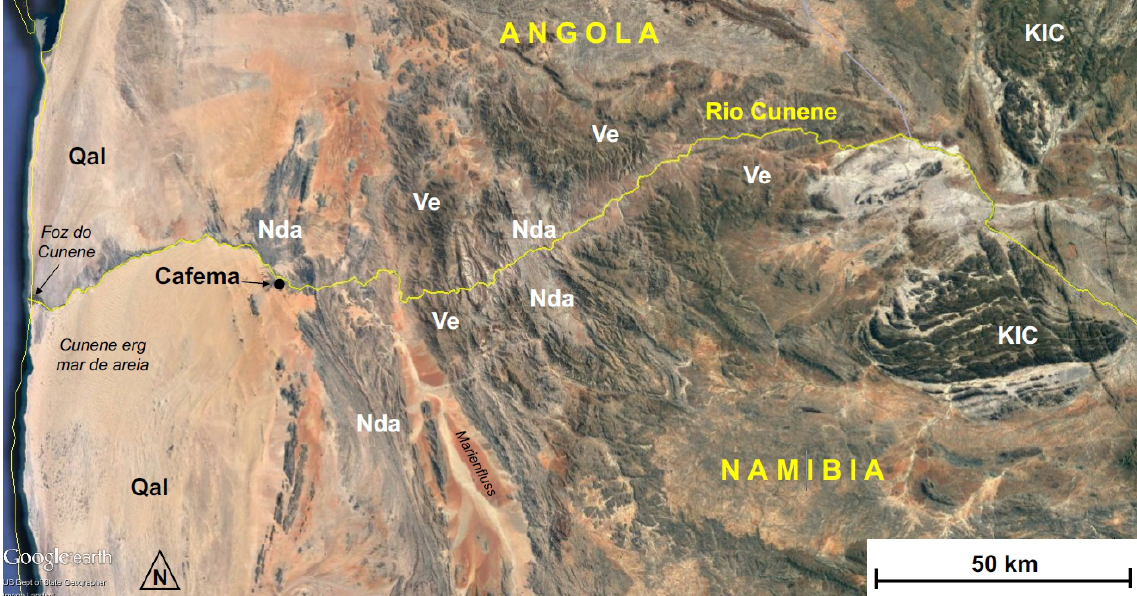
Figura 5. Mapa do sítio do Paleolítico Médio Africano (PMA) Cafema no Google Earth, ao longo do baixo Rio Cunene, fronteira entre Angola e Namíbia. As unidades geológicas de afloramento primário listada na Tabela 3 que contribuem com os clastos do terraço fluvial de Qal. KIC: Complexo Intrusivo Kunene. Ve: Complexo Epupa. Nda - Sequência Damara. Qal: Aluvium Quaternário. Figure 5. Google Earth map of Cafema MSA site, along the Lower Cunene River, Angola-Namibia border. The primary outcropping geologic units listed in Table 3 that contribute clasts to the Qal in the relict river terrace. KIC: Kunene Intrusive Complex. Ve: Epupa Complex. Nda - Damara Sequence. Qal: Quaternary alluvium